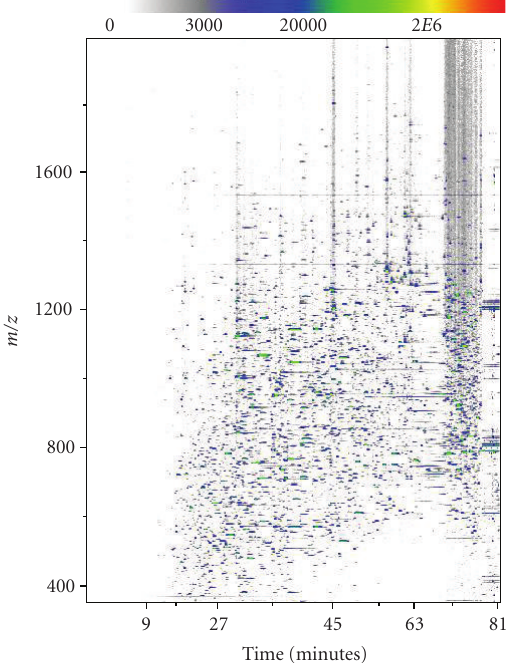
Figure 6: A 2D depiction of the raw MS data from the control- pre sample. The graph plots m/z versus elution time and displays intensity at a given point with color.